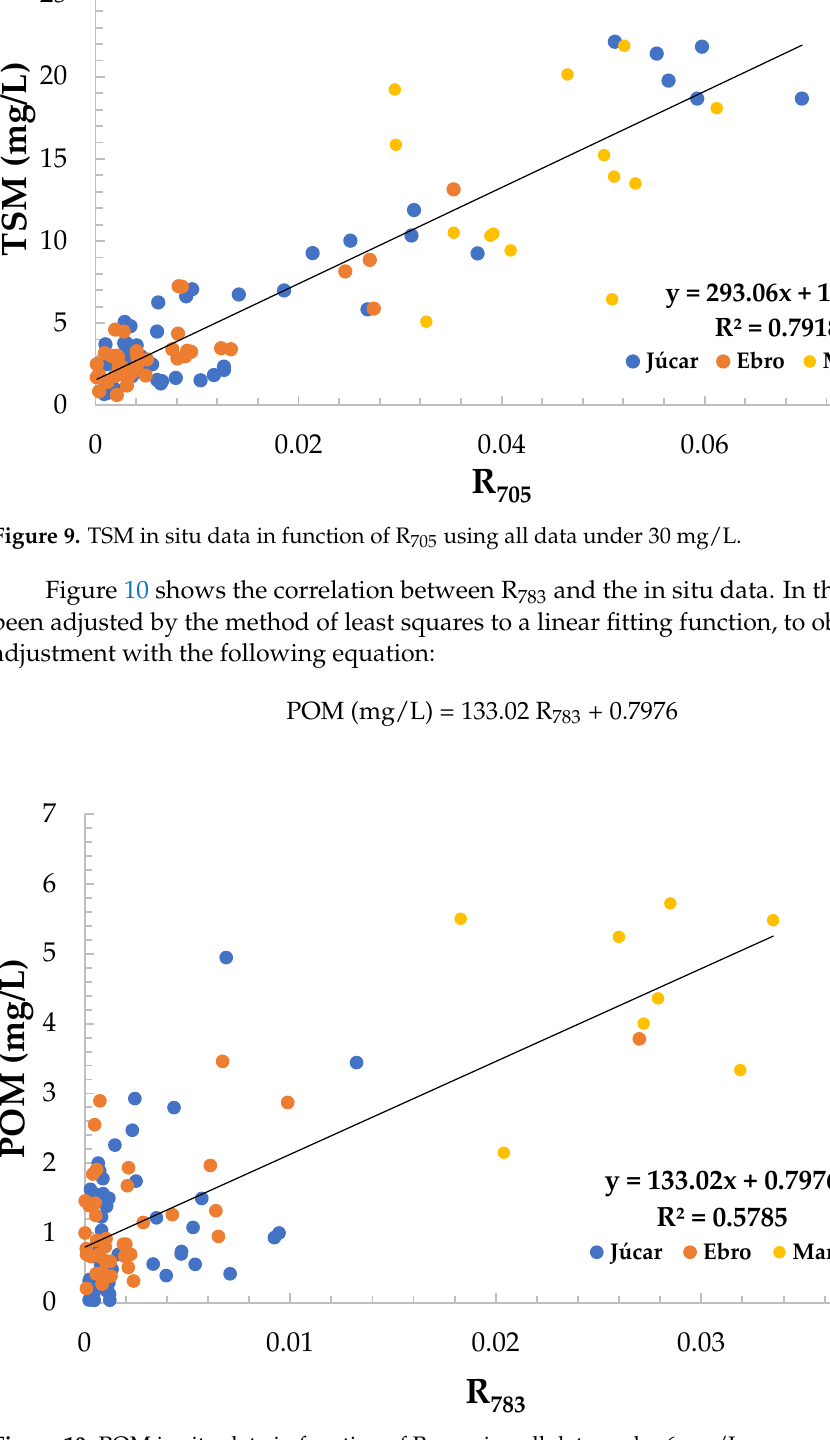
Figure 10. POM in situ data in function of R 783 using all data under 6 mg/L. For PIM, it emerged that R 705 is the one that presents the best correlation (shown in Figure 11) with an error of 1.56 mg/L between measured and estimated data. Adjusting by the method of least squares to a linear fitting function, the best adjust- ments are obtained with the equation: